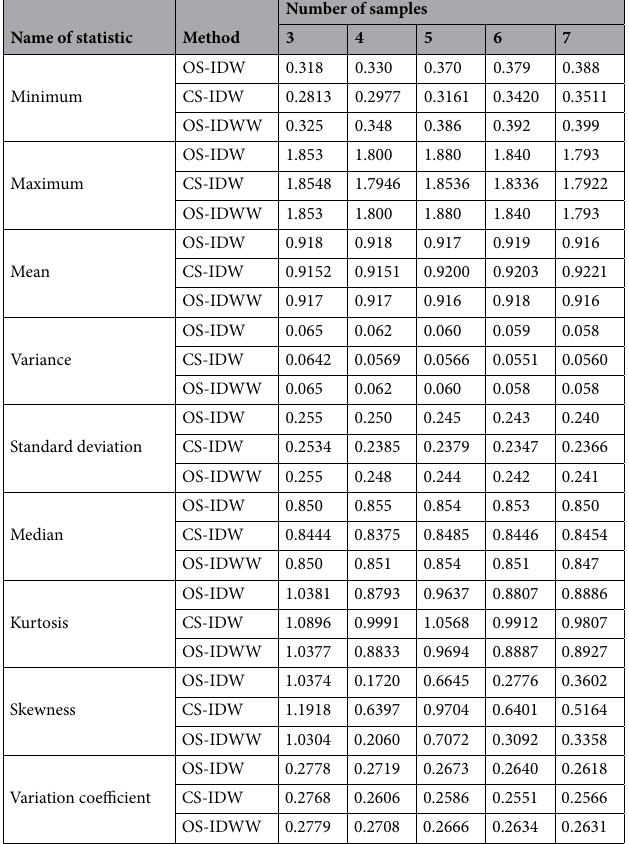
Table 4. Statistics of the Fe grade estimation results.